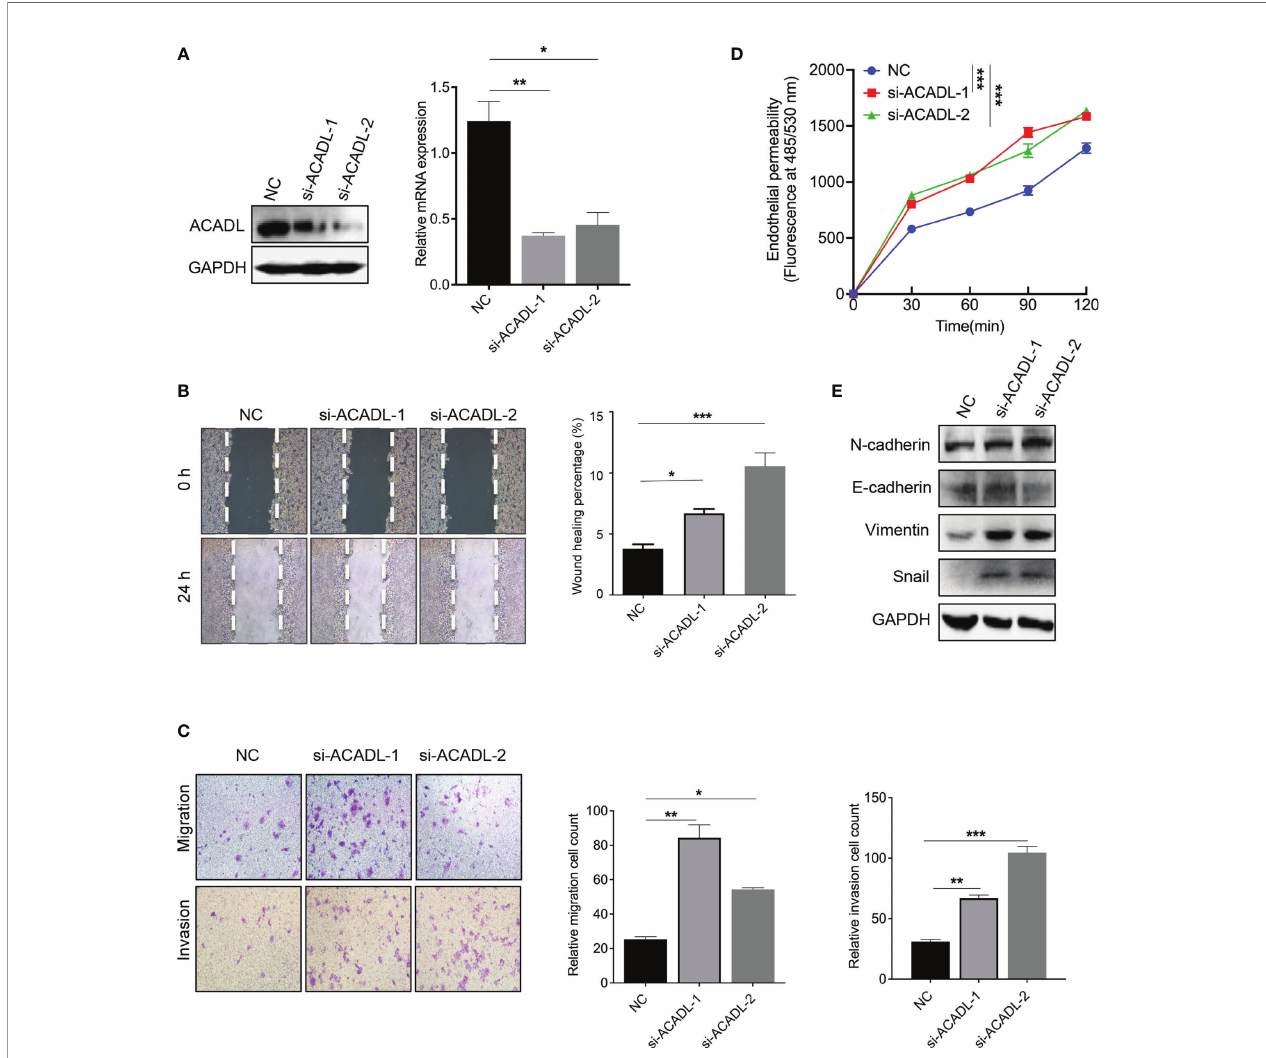
FIGURE 3 | Knockdown of ACADL enhances HCC cell migration and invasion ability. (A) ACADL-knockdown in HepG2 cells was con fi rmed by WB and qRT-RCR analyses. (B) The wound-healing assay shows the migration ability of HepG2 cells after the knockdown of ACADL. Original magni fi cation, 100×. (C, D) Transwell shows the migration and invasion abilities of HepG2 cells after the knockdown of ACADL. Original magni fi cation, 200×. (E) Permeability of HUVEC monolayers was analyzed by measuring the fl uorescence of diffused FITC-dextran (70 kDa) across the Transwell membrane (mean ± SEM, n = 6, paired t test). (F) WB analysis of EMT markers in ACADL-knockdown HepG2 cells. *P < 0.05, **P < 0.01, and ***P < 0.001 compared with